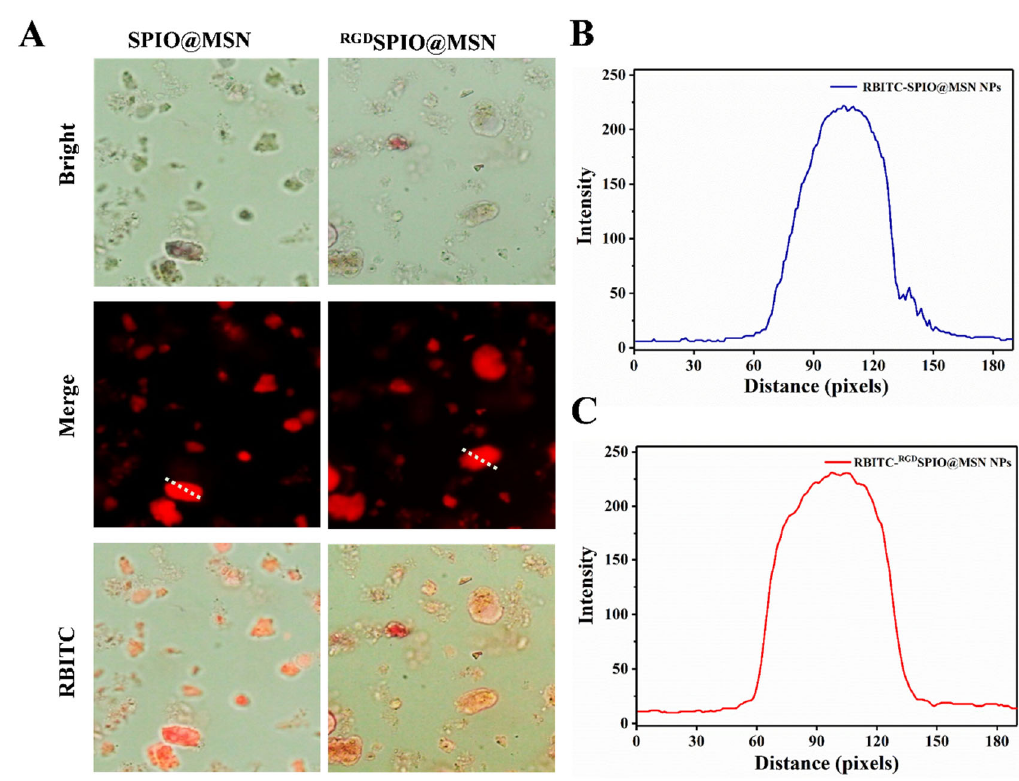
Figure 3. ( A ) Fluorescence images of RBITC-SPIO@MSN NPs and RBITC- RGD SPIO@MSN NPs, and ( B ) the corresponding quantified linear fluorescence intensity of RBITC-SPIO@MSN NPs, and ( C ) RBITC- RGD SPIO@MSN NPs, analyzed using Software Image-Pro Plus 6.0.